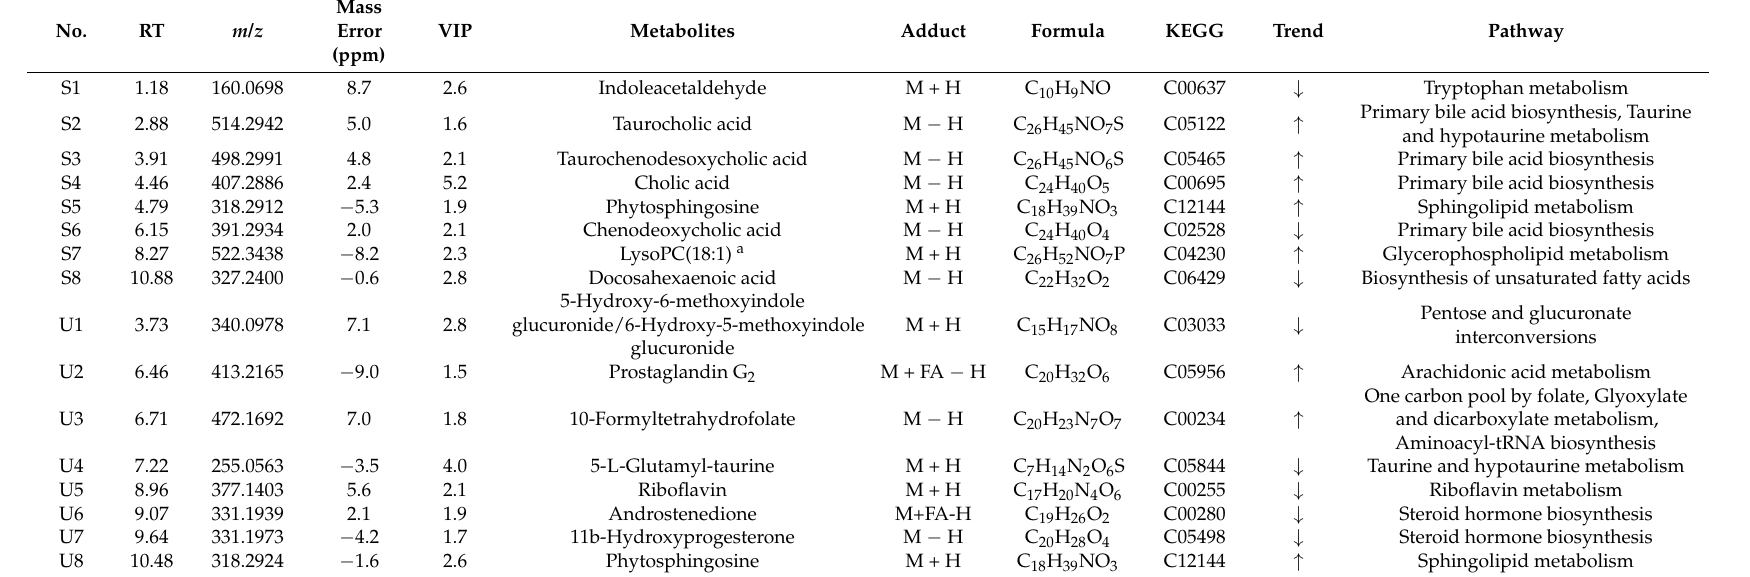
Table 1. Identification results of potential serum and urine metabolites by